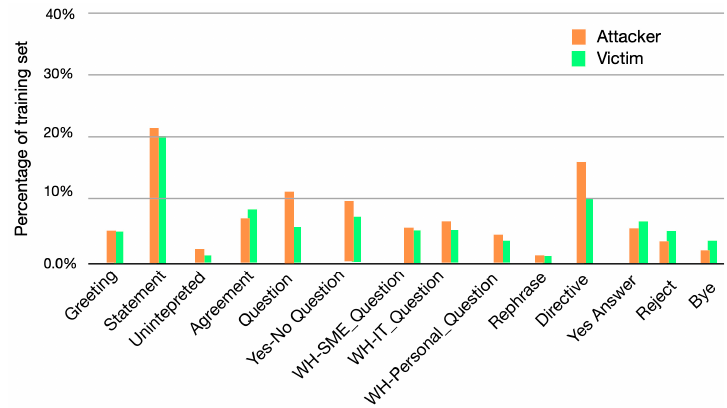
Figure 5. Distribution of types of dialogue acts in the SG-CSE Corpus.